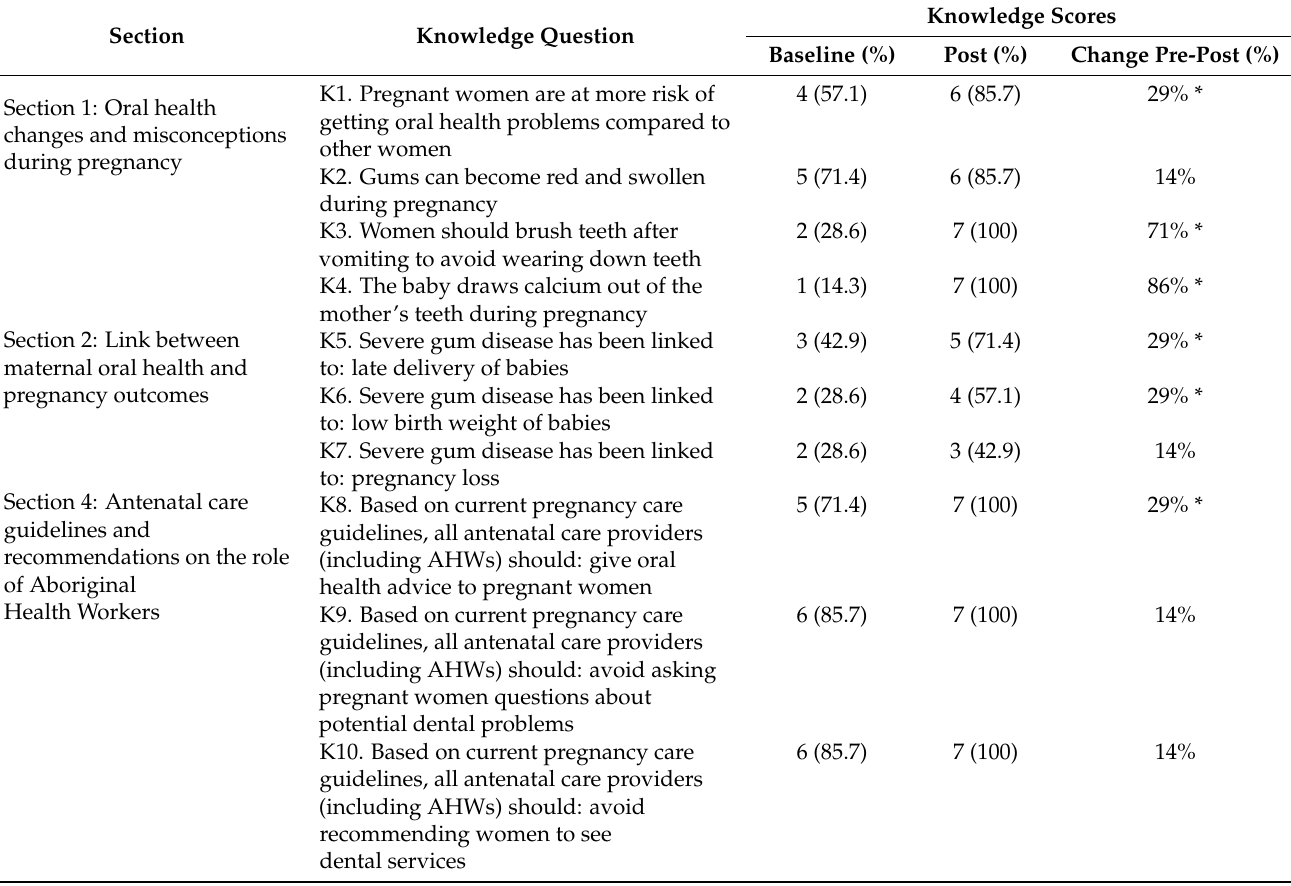
Table 3. Change in oral health knowledge pre–post